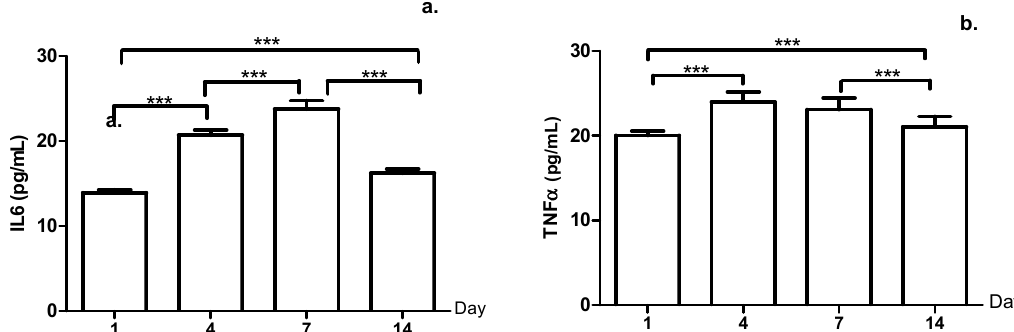
Figure 2. ( a ) Levels of Interleukin-6 (IL6); ( b ) levels of Tumor Necrosis Factor-alfa (TNF α ) during the micro-cycle, ***: p -value < 0.001.